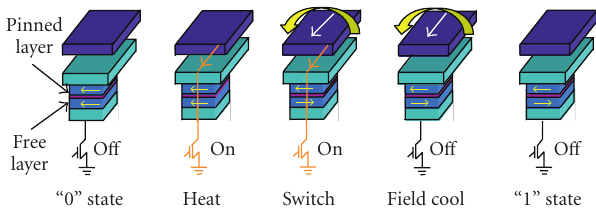
Figure 7: Step sequences of TAS write operation in an MTJ element.